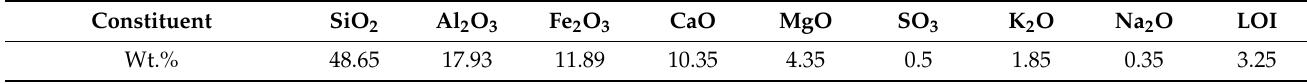
Table 1. Chemical composition of the study pozzolan.